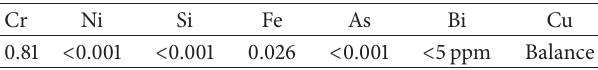
Table 4: Chemical composition of the investigated CuCr alloy, wt%.